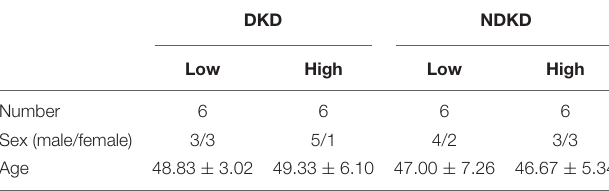
DKD, diabetic kidney disease; NDKD, diabetic without kidney disease.